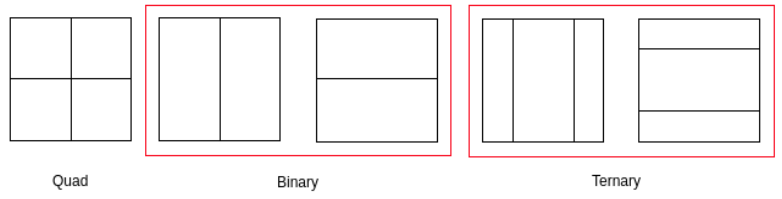
Figure 2. VVC supported partitioning schemes: quad, binary and ternary splitting